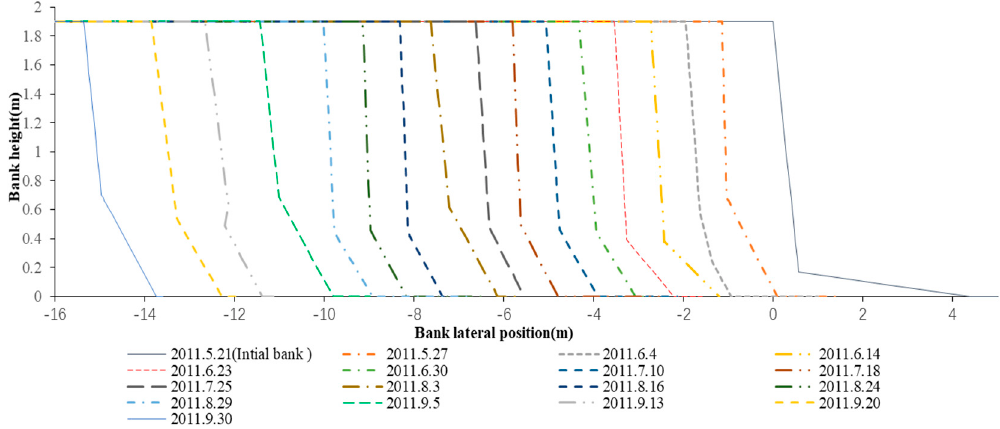
Figure 6. Collapse phases for surveying Section 1.